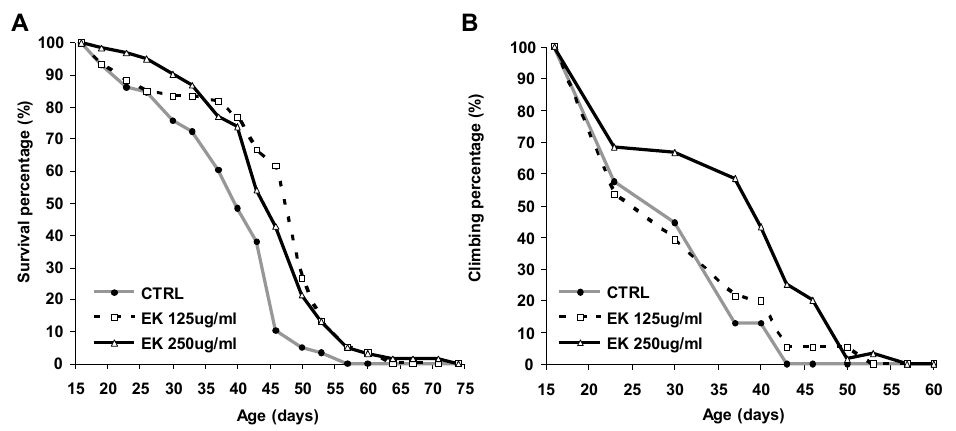
Figure 1. Ergosta-7,9(11),22-trien-3 β -ol improved the survival and climbing of AD Drosophila. ( A ) Survival curve of AD Drosophila treated with different doses of ergosta-7,9(11),22-trien-3 β -ol. ( B ) Climbing curve of AD Drosophila treated with different doses of ergosta-7,9(11),22-trien-3 β -ol. CTRL denotes drug-free control, while EK denotes ergosta-7,9(11),22-trien-3 β -ol (EK100).